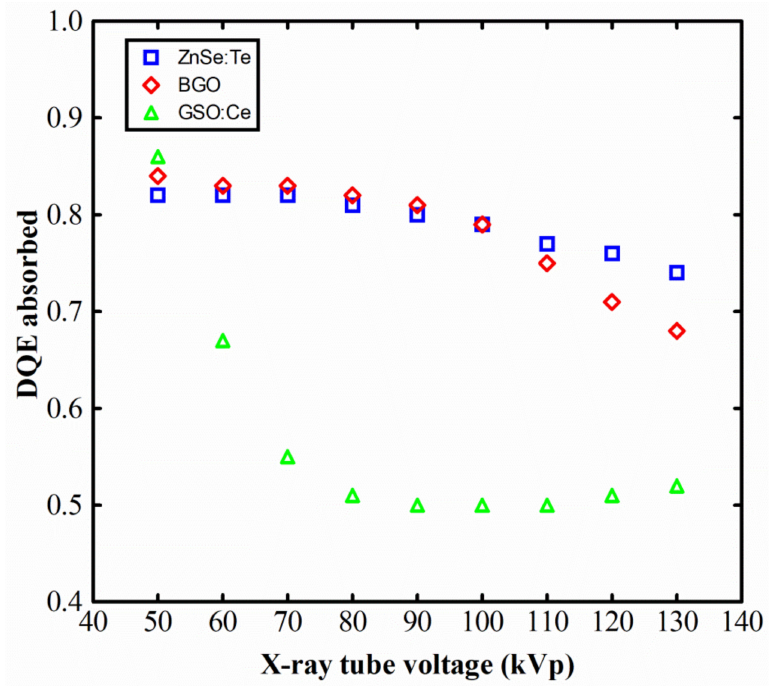
Figure 6. Detective quantum e ffi ciency absorbed of ZnSe: Te, BGO and GSO: Ce. Absolute luminescence e ffi ciency values for the three crystals as a function of the set tube high-voltage are presented in Figure